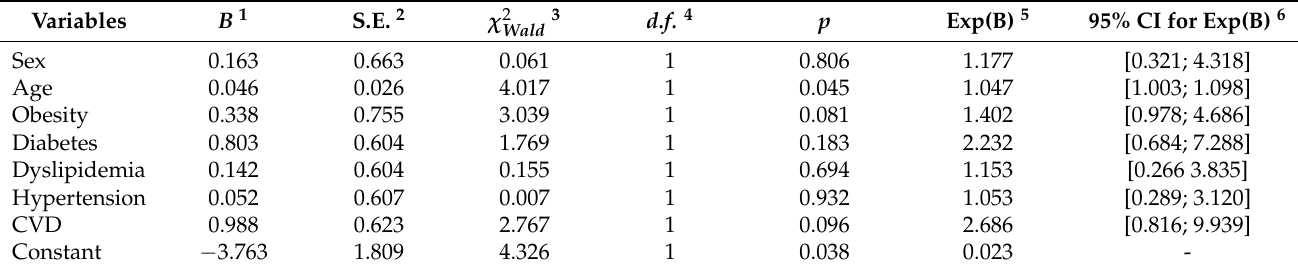
Table 3. Results of logistic regression model using the Enter selection